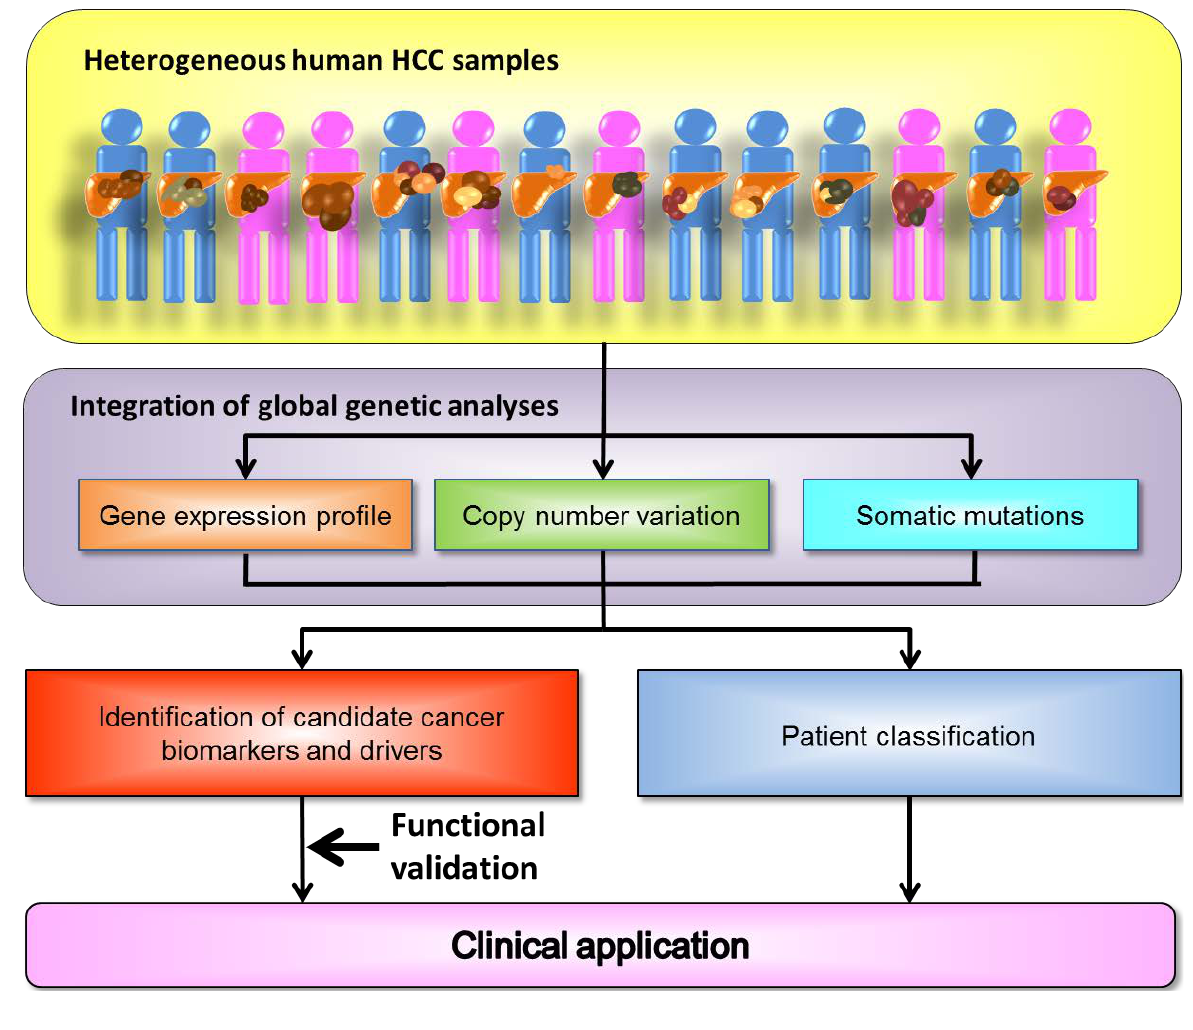
Figure 1. Strategies for the identification of cancer driver genes or